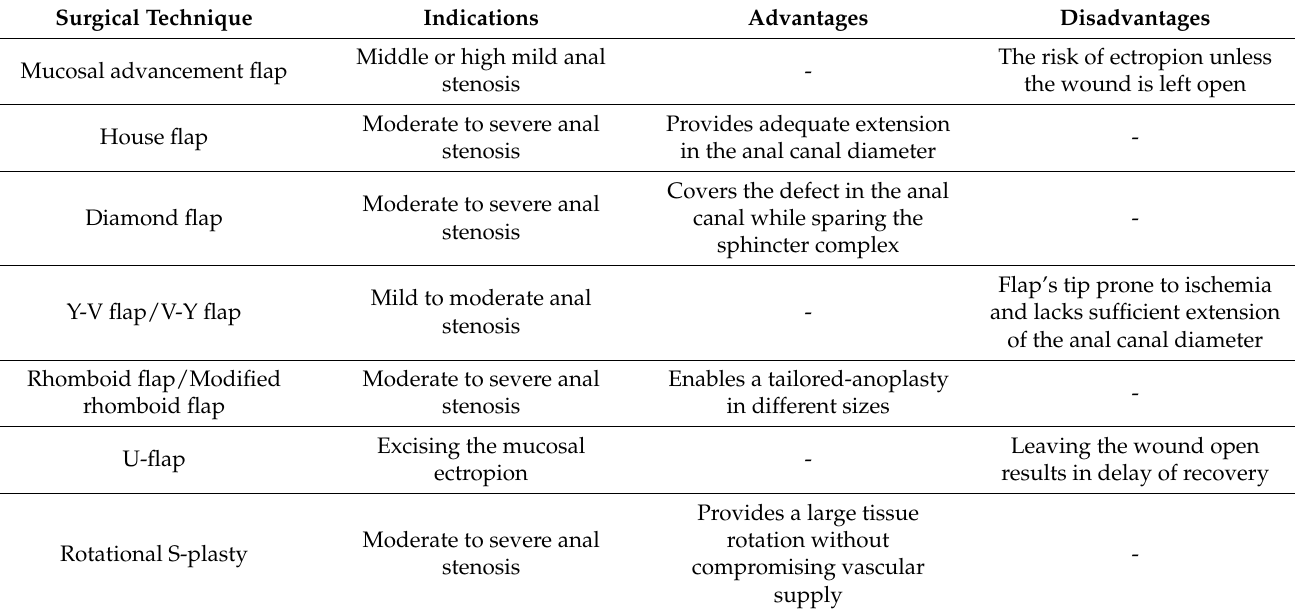
Table 2. Common surgical techniques used for treating anal